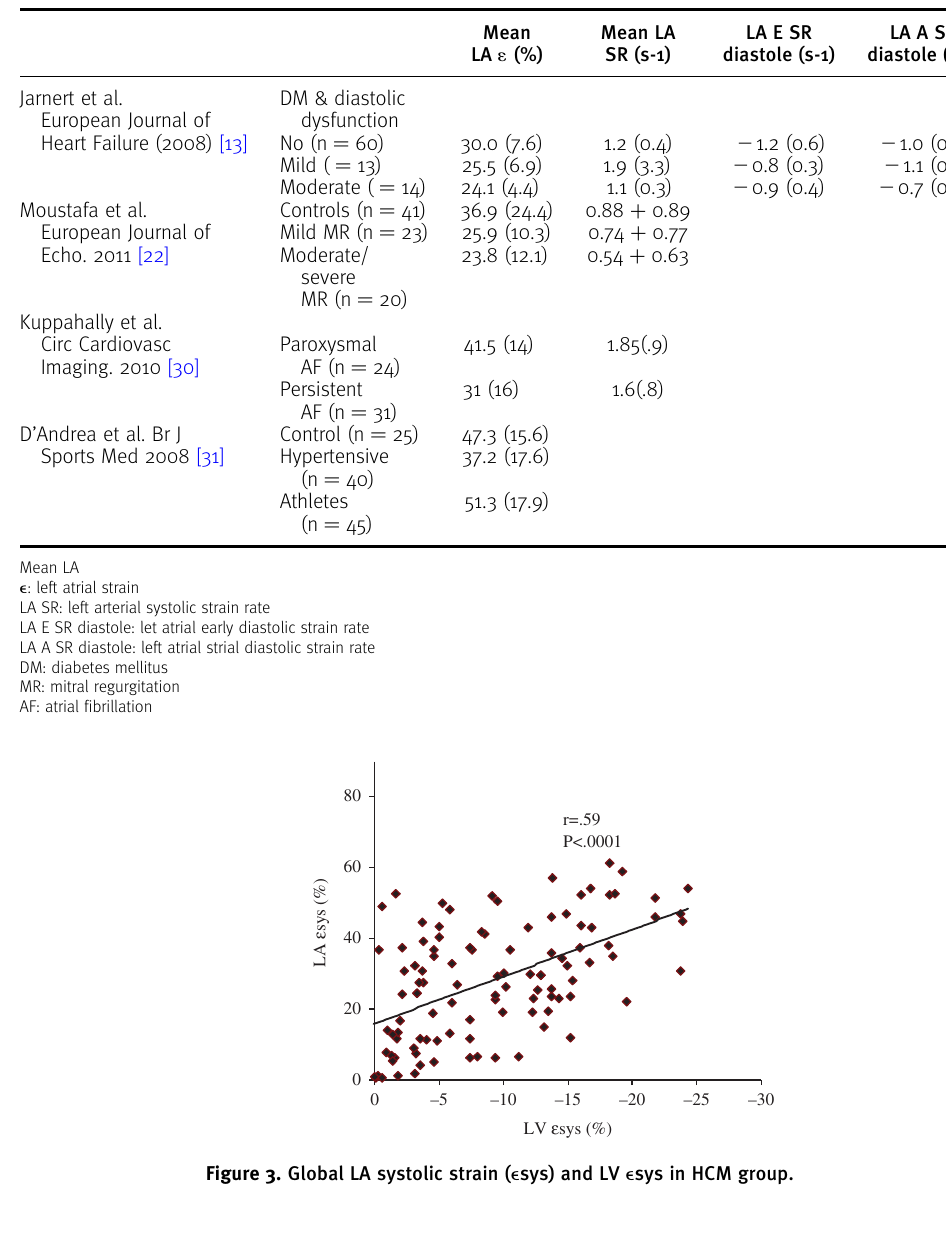
Table 4. Left atrial deformation using VVI in other pathological states.